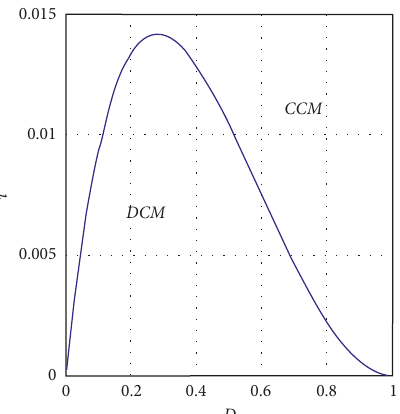
Figure 10: Boundary condition of the HS-LC